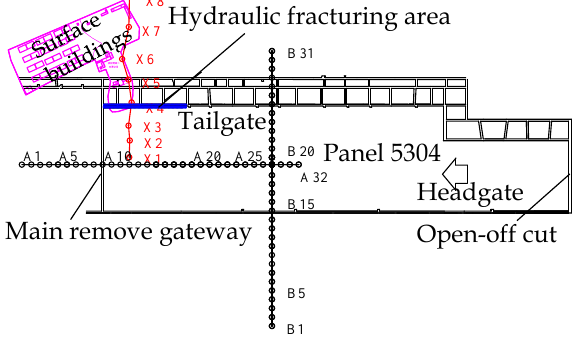
Figure 16. Layout of surface displacement observation station.